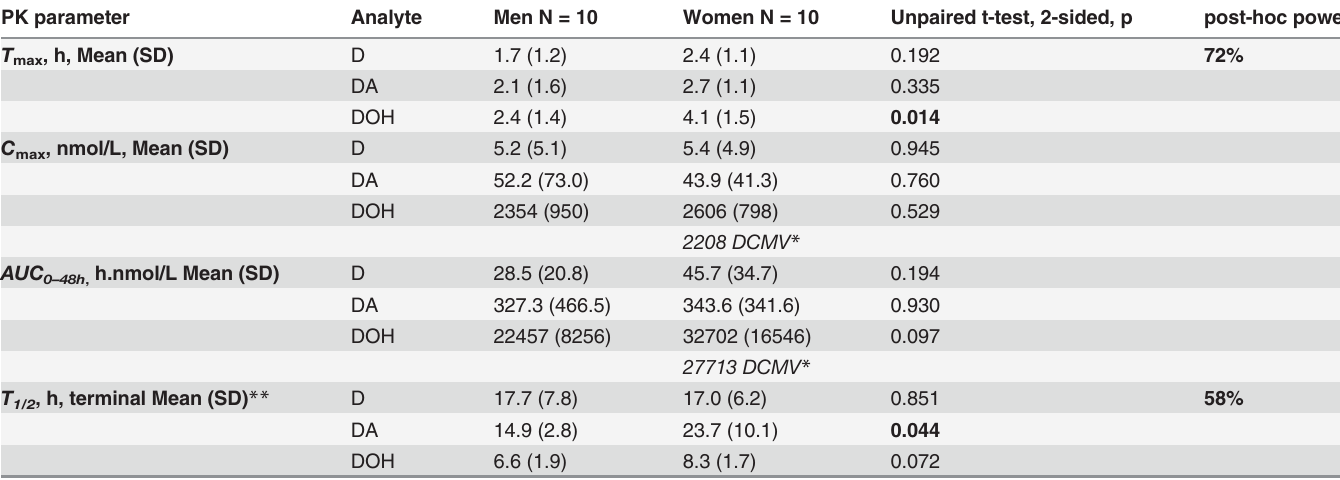
Table 3. Comparison of pharmacokinetic parameters of decursin (D), decursinol angelate (DA) and decursinol (DOH) in men vs. women receiving dietary supplement Cogni.Q orally. PK